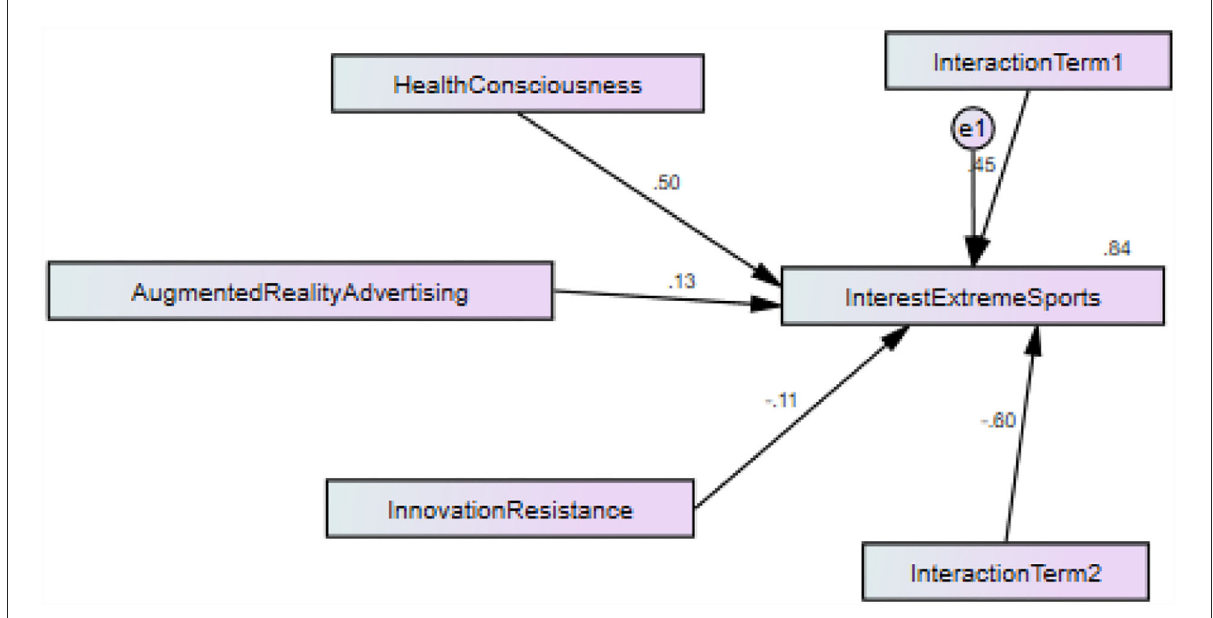
FIGURE4 Structural model assessment.